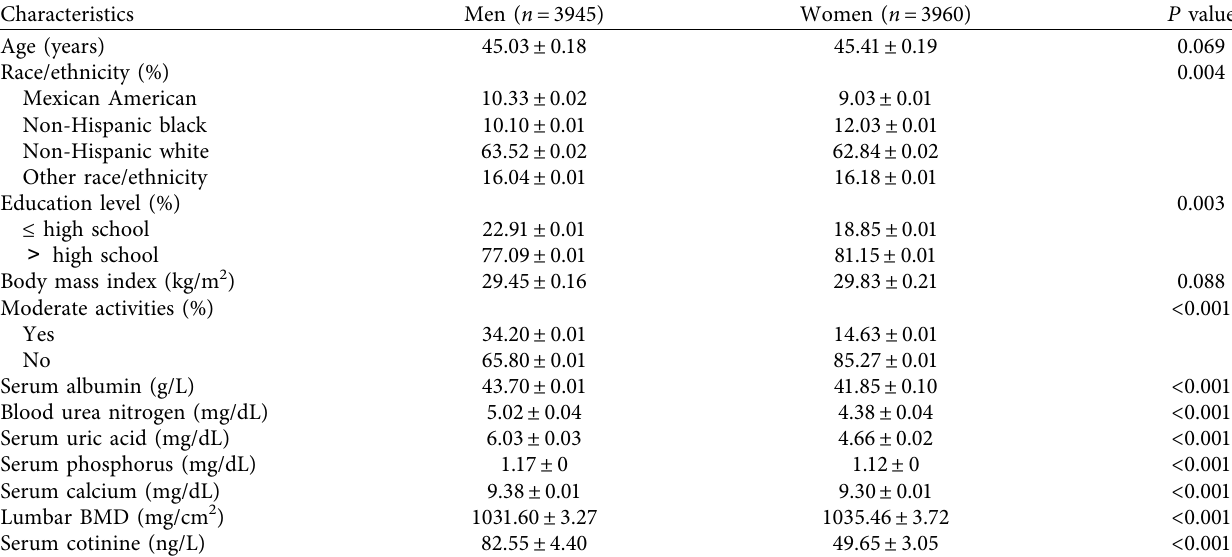
Table 1: Weighted characteristics of study participants.